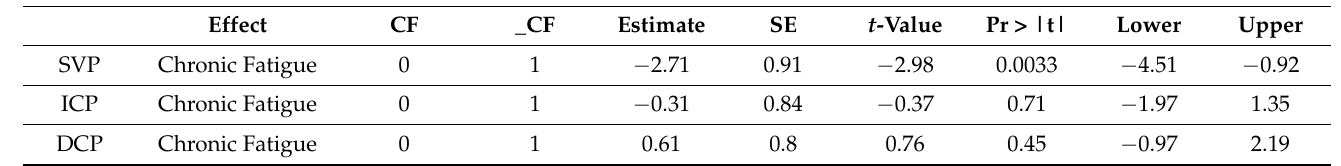
Table 2. Differences in least square means of VD in the SVP, ICP and DCP in patients with post- COVID-19 syndrome (PCS) with chronic fatigue (CF, 1) and without CF (0). A notable significant effect was observed in the SVP ( p =